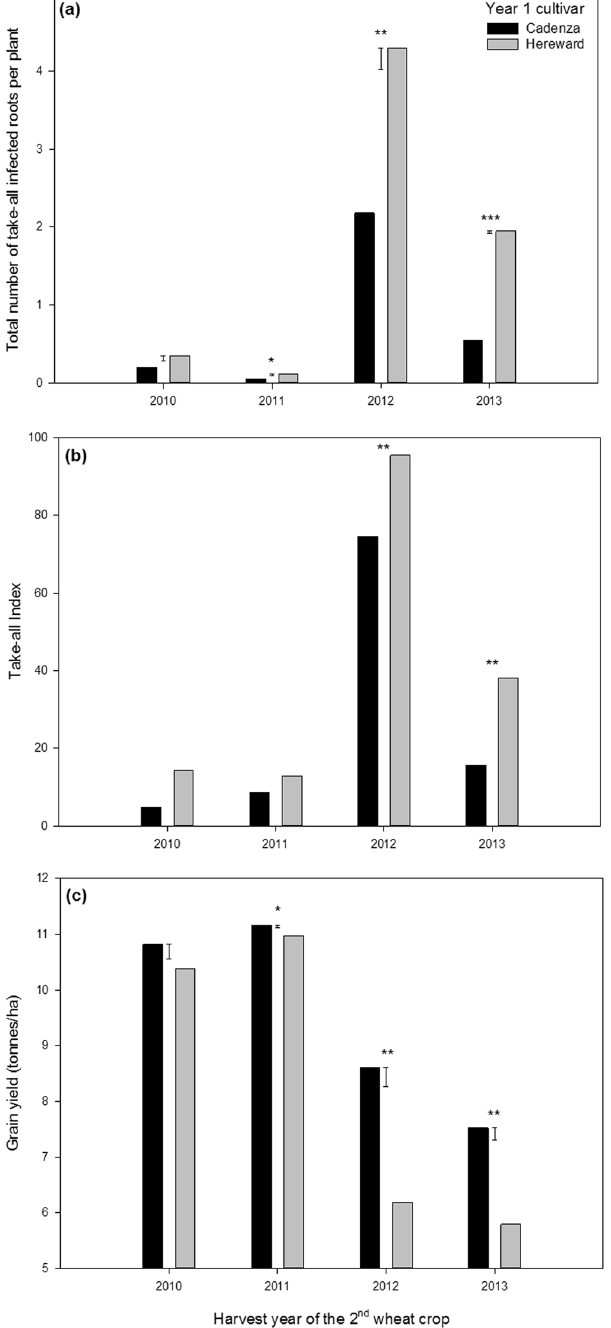
Figure 1. Mean take-all disease severity on the roots in the spring ( a ) and summer ( b ) and grain yield ( c ) of the eight winter wheat cultivars sown as a second wheat crop after the low TAB cultivar Cadenza and high TAB cultivar Hereward were sown in the first year of wheat cropping. Error bars in panels (a) and (c) show the standard error of the difference between the means for comparisons in each year. In panel (b) the back- transformed means on the take-all index scale are shown (Logit of the take-all index: 2010, Cadenza = − 1.432, Hereward = − 0.873, SED = 0.183; 2011, Cadenza = − 1.151, Hereward = − 0.931, SED = 0.094; 2012, Cadenza = 0.550, Hereward = 1.578, SED = 0.114; 2013, Cadenza = − 0.823, Hereward = − 0.232, SED = 0.054). * Significantly different from zero at the 0.05 level of probability, ** Significantly different from zero at the 0.01 level of probability, *** Significantly different from zero at the 0.001 level of